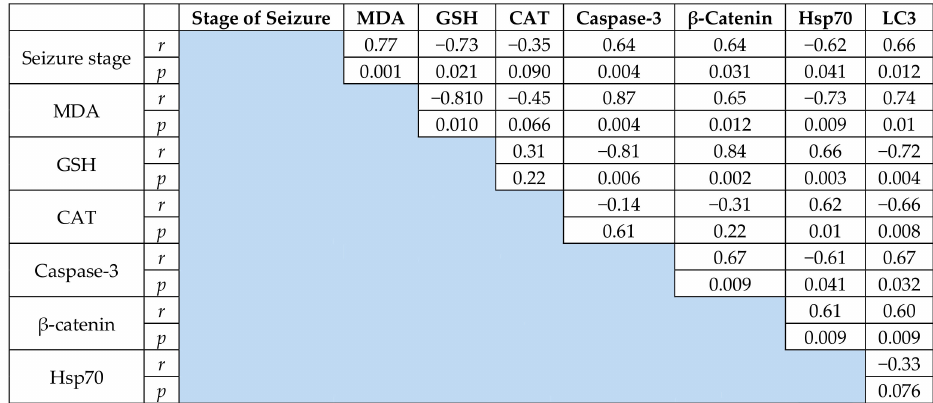
Table 1. Correlation between seizure stage and MDA, GSH, CAT, caspase-3, β -catenin, LC3 and Hsp70 in PTZ